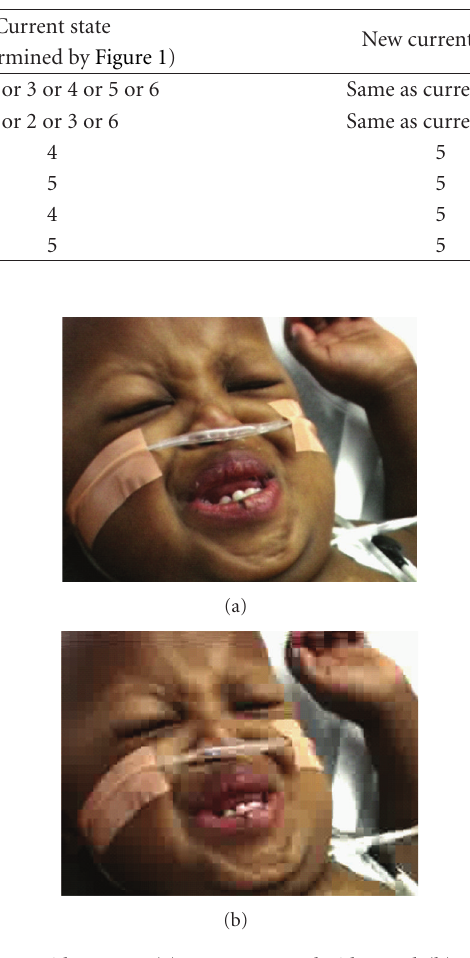
Figure 4: Video Er08. (a) Uncompressed video and (b) Uniform compression at 500 kbps.